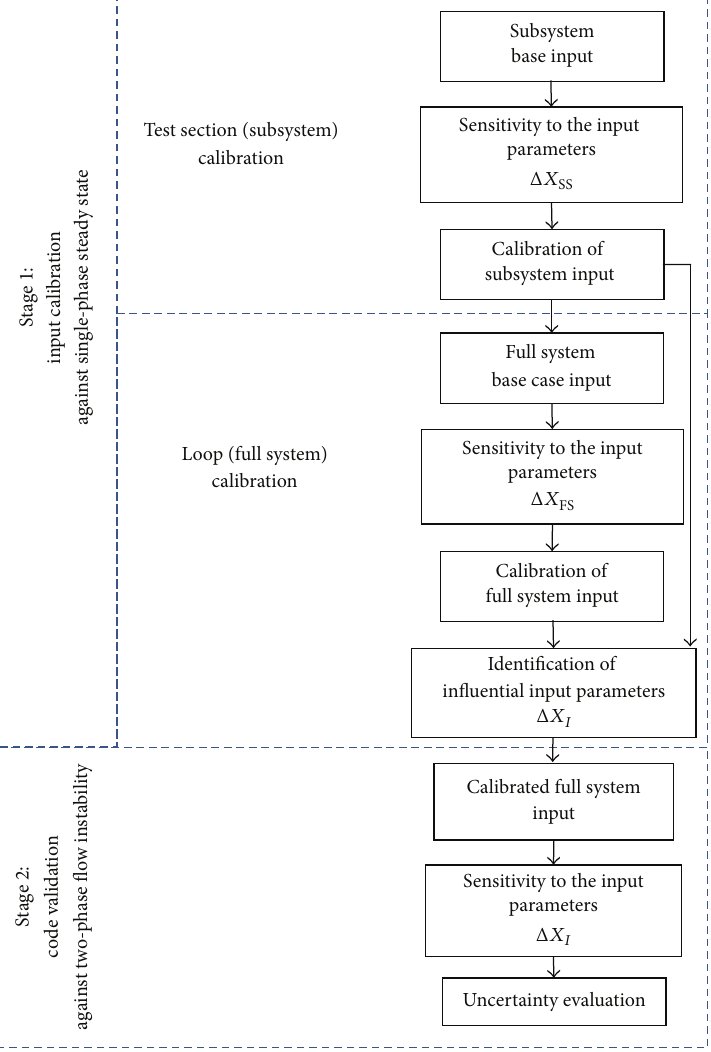
Figure 4: The procedure for input calibration and code validation with uncertainty